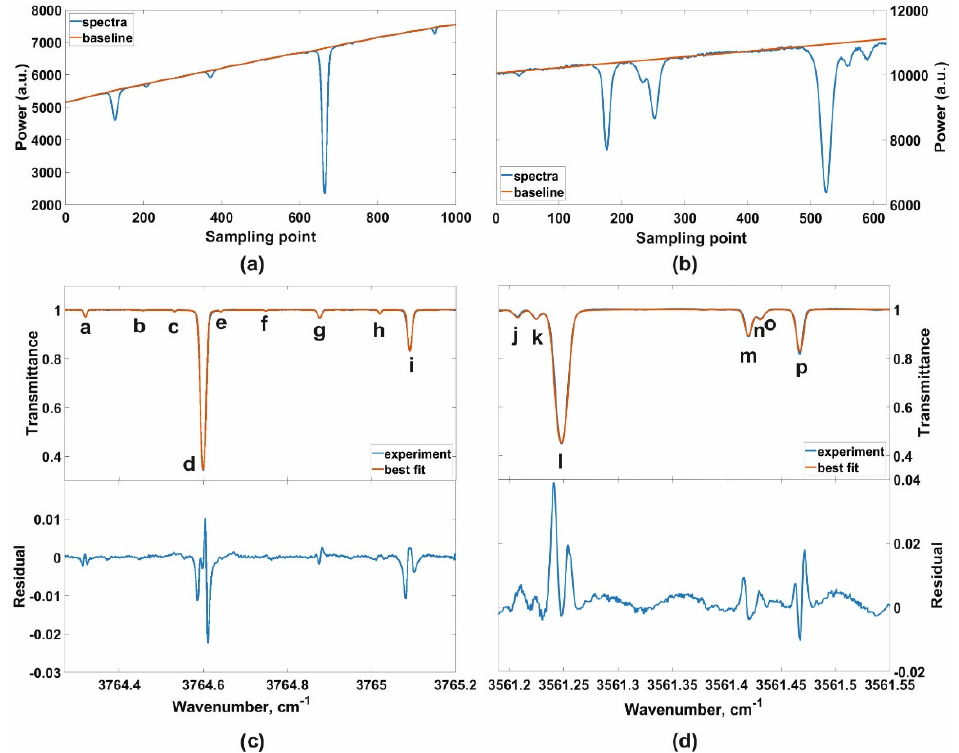
Figure 9. Experimental data of the M-DLS. ( a , b ) raw spectra (blue curves) and approximated baselines (red curves) for 2.656 µ m and 2.808 µ m respectively. ( c , d ) normalized transmittance spectra (blue curves) with synthetic spectra (red curves) and residual at separate graphs (blue curves) for 2.656 µ m and 2.808 µ m, respectively. Line identifiers from “a” to “p” are deciphered in the discussion section.